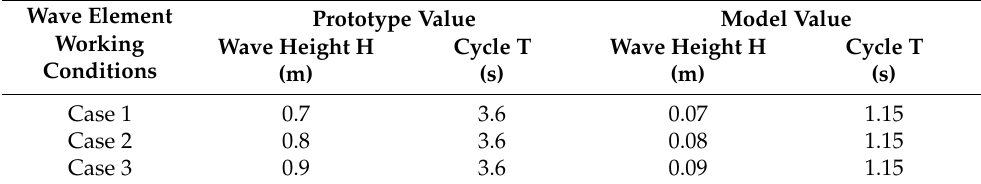
Table 1. Regular wave working conditions chart.